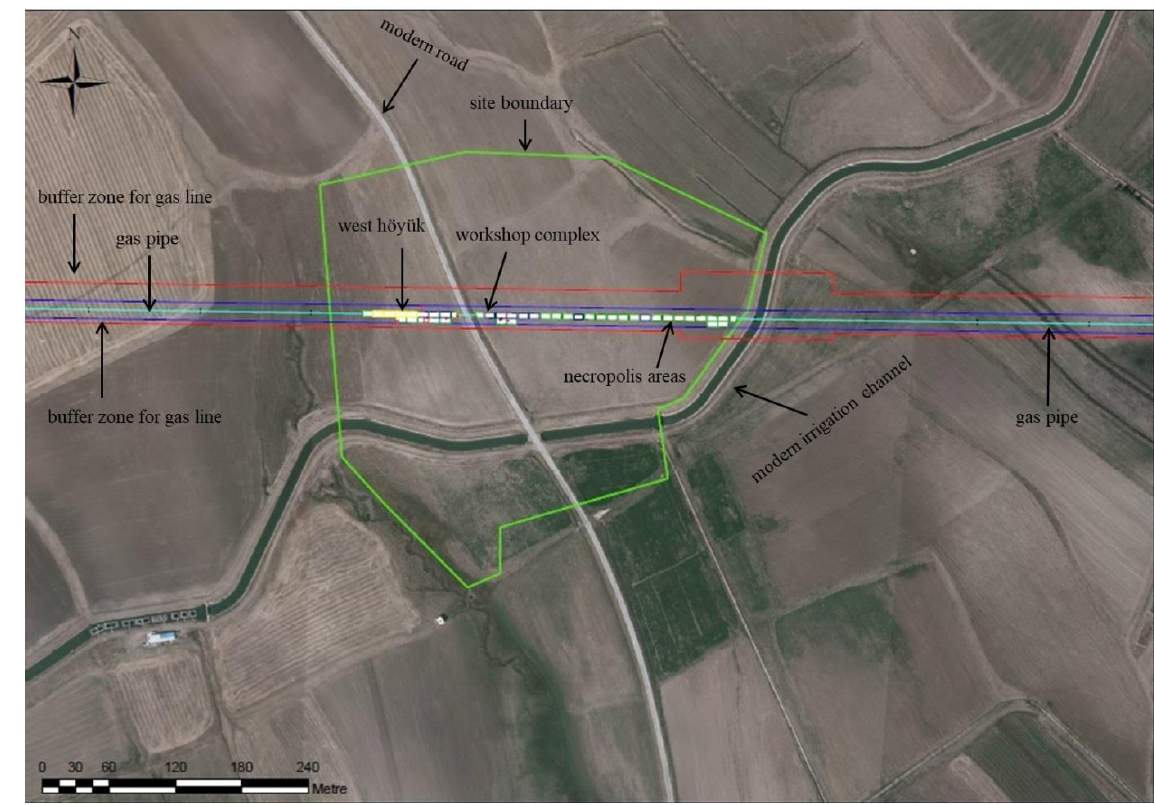
Figure 2. Topography and excavated areas of Alaybeyi Höyük: the modern road divided the site in east and west sections (photo from Alaybeyi Höyük Archive).